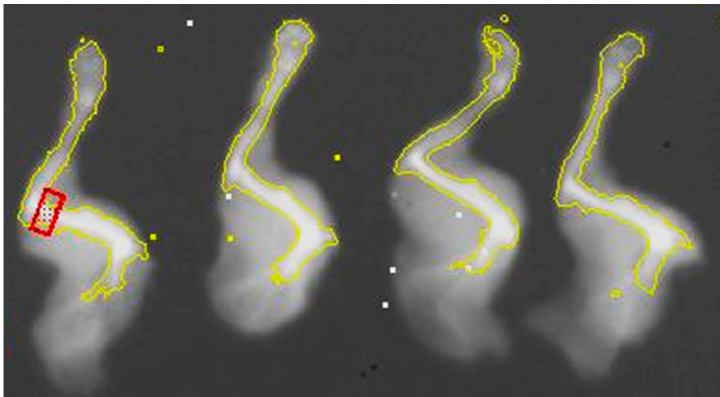
Figure 2. Example of humerus bone distal region dual-energy X-ray absorptiometry analysis. Mouse dissected left forelimbs were scanned in groups of n = 4. Images were adjusted for high contrast. A small ROI (red box) was placed at the distal end of the humerus bone in the approximate region where bone densities and epiphyseal plate thickness were measured. Site-specific BMC and BMD were then analyzed.